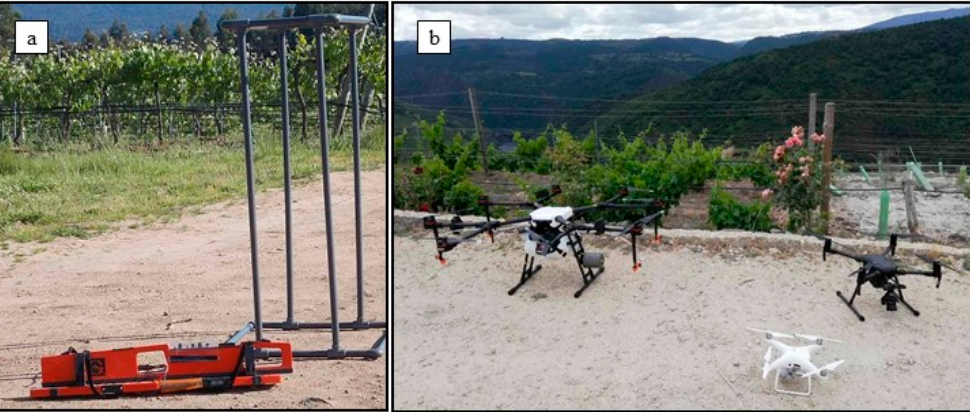
Figure 5. Examples of equipment for proximal and remote sensing employed in vineyards: ( a ) Electromagnetic induction sensor with plastic structure for its calibration; ( b ) Three different models of unmanned aerial vehicles. Photos were taken by J.M. Mirás-Avalos.